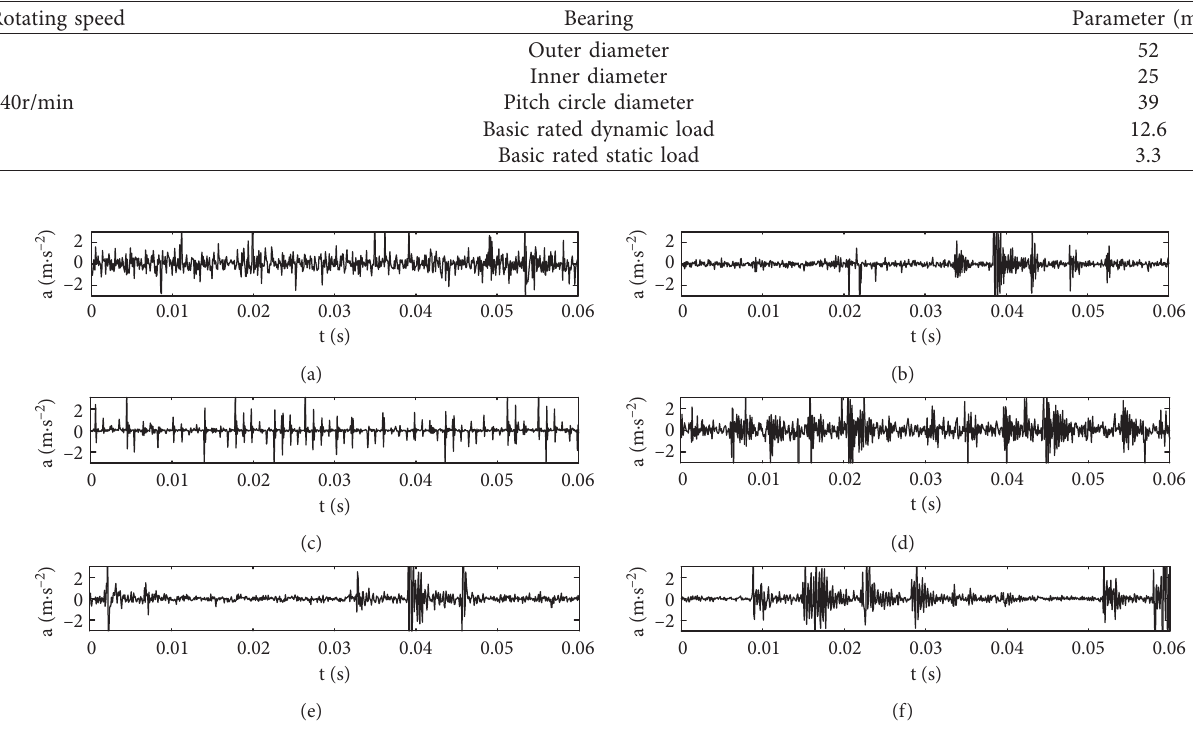
Figure 4: Fault signals under different working conditions. (a) ∼ (f) are fault signals of BR, LBR, OR, LOR, IR, and LIR, respectively.